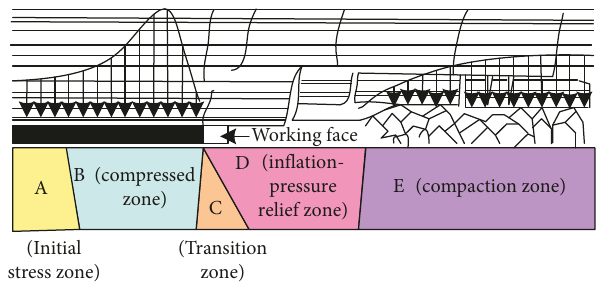
Figure 1: Simulated diagram of coal seam floor failure.